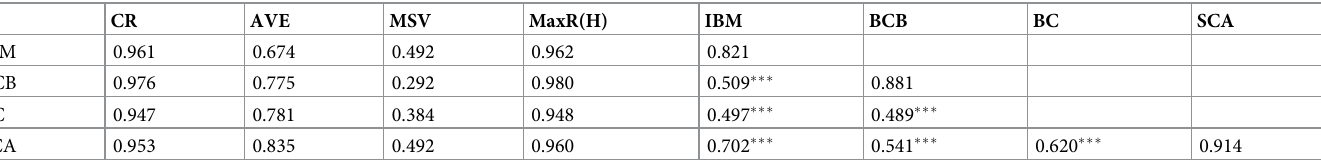
Table 3. Discriminant validity.